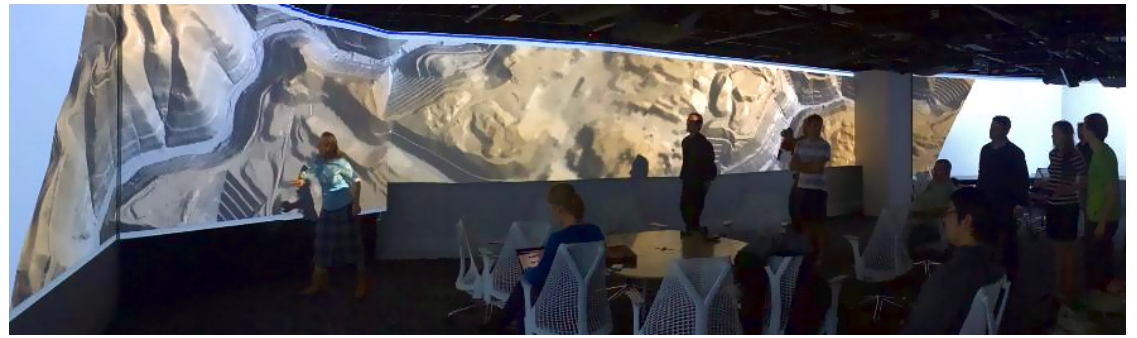
Figure 5. Students in the Multidimensional Geospatial Modeling course visualizing a digital elevation model of an area affected by mountaintop mining in the Hunt Library Teaching and Visualization